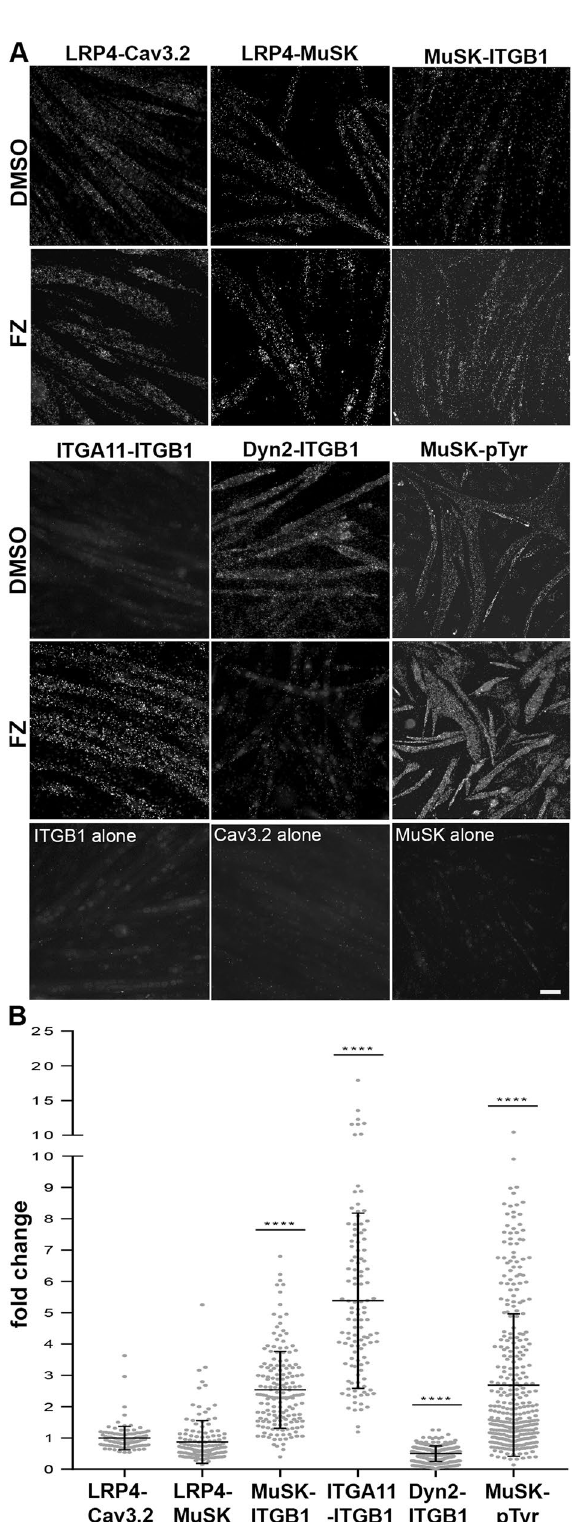
Figure 6. Visualization of key NMJ protein interactions in flunarizine-treated C2C12 myotubes. ( A) In situ PLA detection of endogenous protein interactions in C2C12 myotubes with specific antibodies for the following protein pairs: LRP4-MuSK, LRP4-Cav3.2, MuSK-integrin β1, integrin α11-β1, Dyn2-integrin β1 and MuSK- phosphotyrosines. As negative controls, one primary antibody is omitted or replaced by a negative control antibody (DAKO). The PLA positive signals are shown as bright dots. ( B ) Fold change in mean fluorescence intensity of individual C2C12 myotubes detected in panel A is shown. The number of myotubes analysed with ImageJ is found in supplemental Table 3. Scale bar, 30